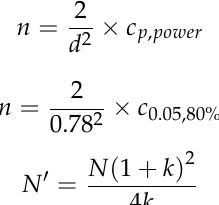
Table 1. Anamnestic data: PN = Peripheral Neuropathy, C = healthy controls, Risk classification according to [3], N.a = not available, * = p < 0.05.